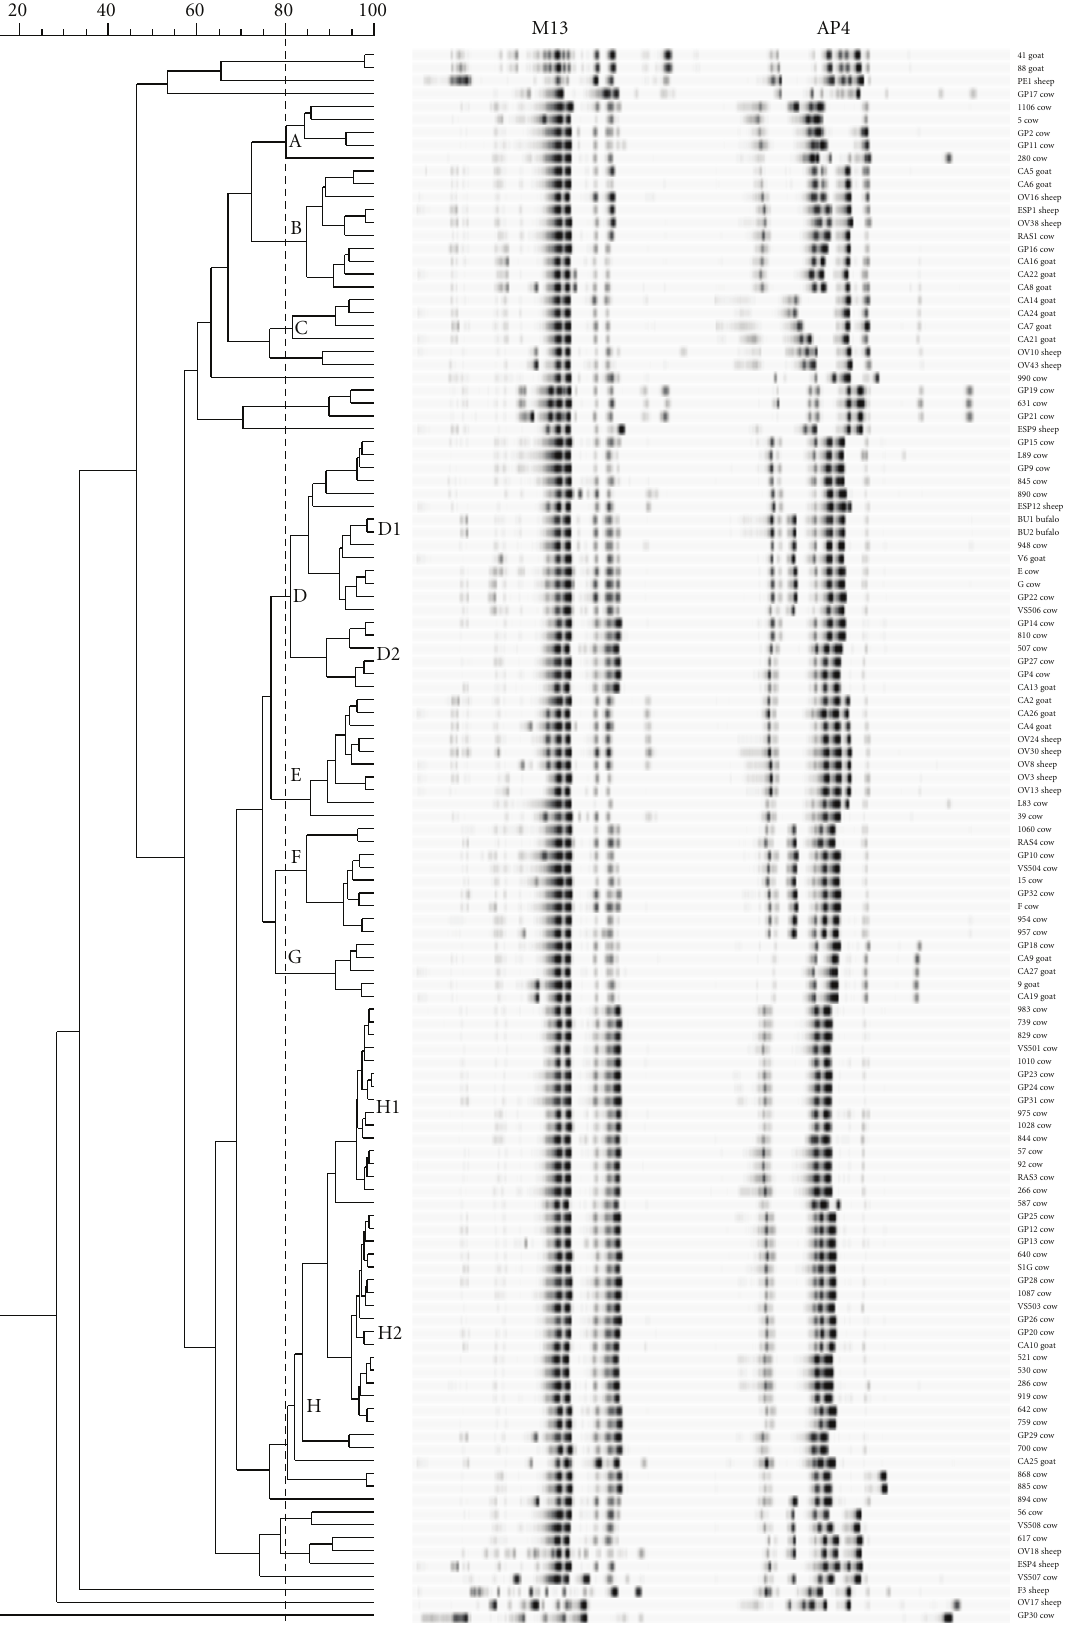
Figure 1: Dendrogram derived from the RAPD-PCR profiles generated with primers M13 and